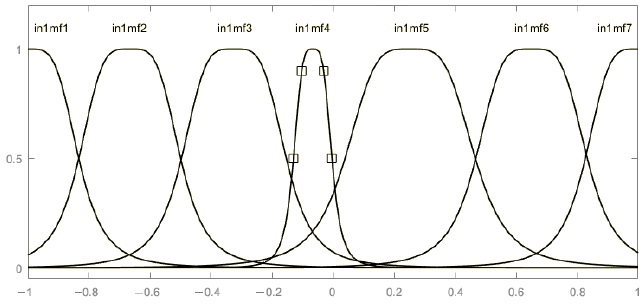
Figure 10. Membership functions at the input of ANFIS.